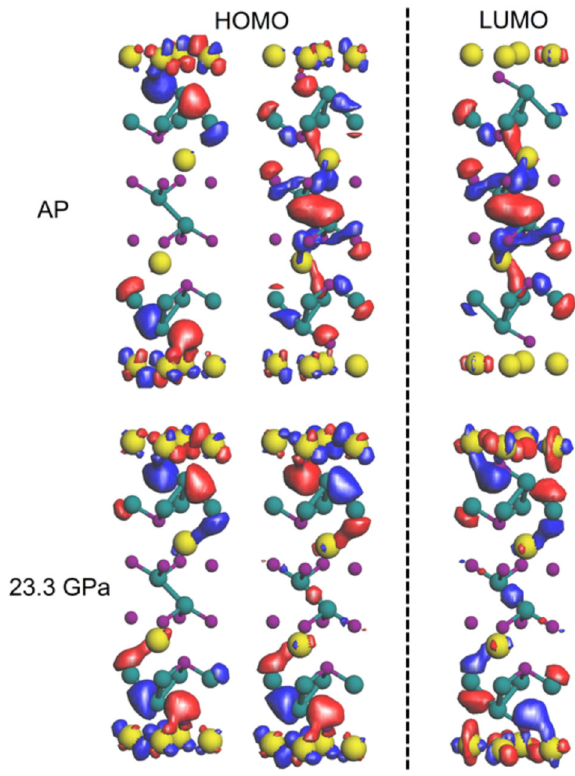
Fig. 7 Molecular orbitals calculations. Doubly-degenerated ( e g ) HOMOs of EuSn 2 P 2 (left) and LUMO of EuSn 2 P 2 (right) at ambient pressure (AP) and 23.3 GPa. Yellow, cyan and purple balls represent Eu, Sn and P atoms, respectively. Blue and Red colors indicate the opposite orbital symmetry.